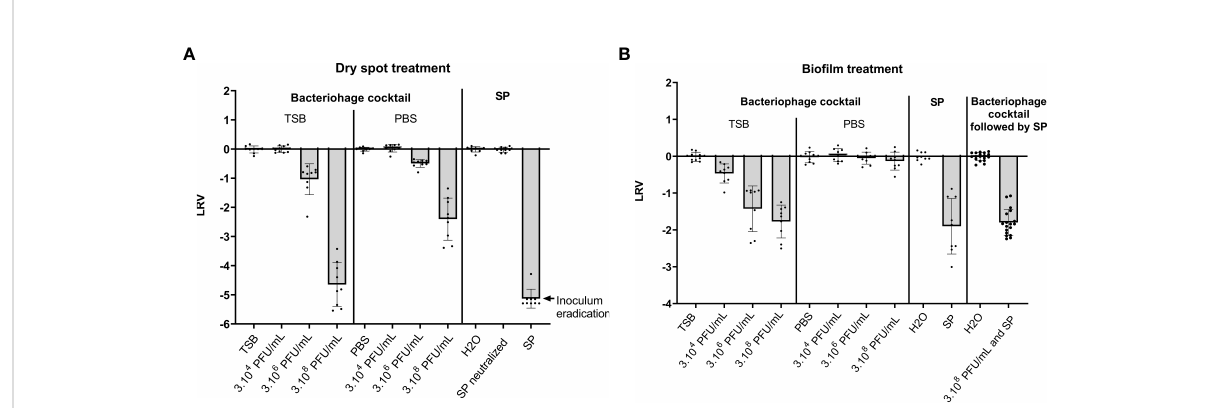
FIGURE 1 Effect of a bacteriophage cocktail and Surfanios Premium on dry spots and pre-formed bio fi lms of S. capitis NRCS-A. Results are presented as Log 10 reduction values (LRV) calculated as Log10(N/N0) with N the remaining inoculum after treatment and N0 the remaining inoculum after treatment with diluent (TSB or PBS for treatment with bacteriophages and water for treatment with SP). The treatments consisted either of i) bacteriophage cocktails at three concentrations (3.10 4 PFU/mL, 3.10 6 PFU/mL or 3.10 8 PFU/mL) in TSB or in PBS, ii) Surfanios Premium (SP) at 0.25% in water or iii) a sequential treatment with the bacteriophage cocktail at the highest concentration (3.10 8 PFU/mL) in TSB followed by SP treatment. (A) Effect of the bacteriophage cocktails or SP individually on bacterial dry spots. (B) Effect of the bacteriophage cocktails or SP individually or sequentially on pre-formed bio fi lms.